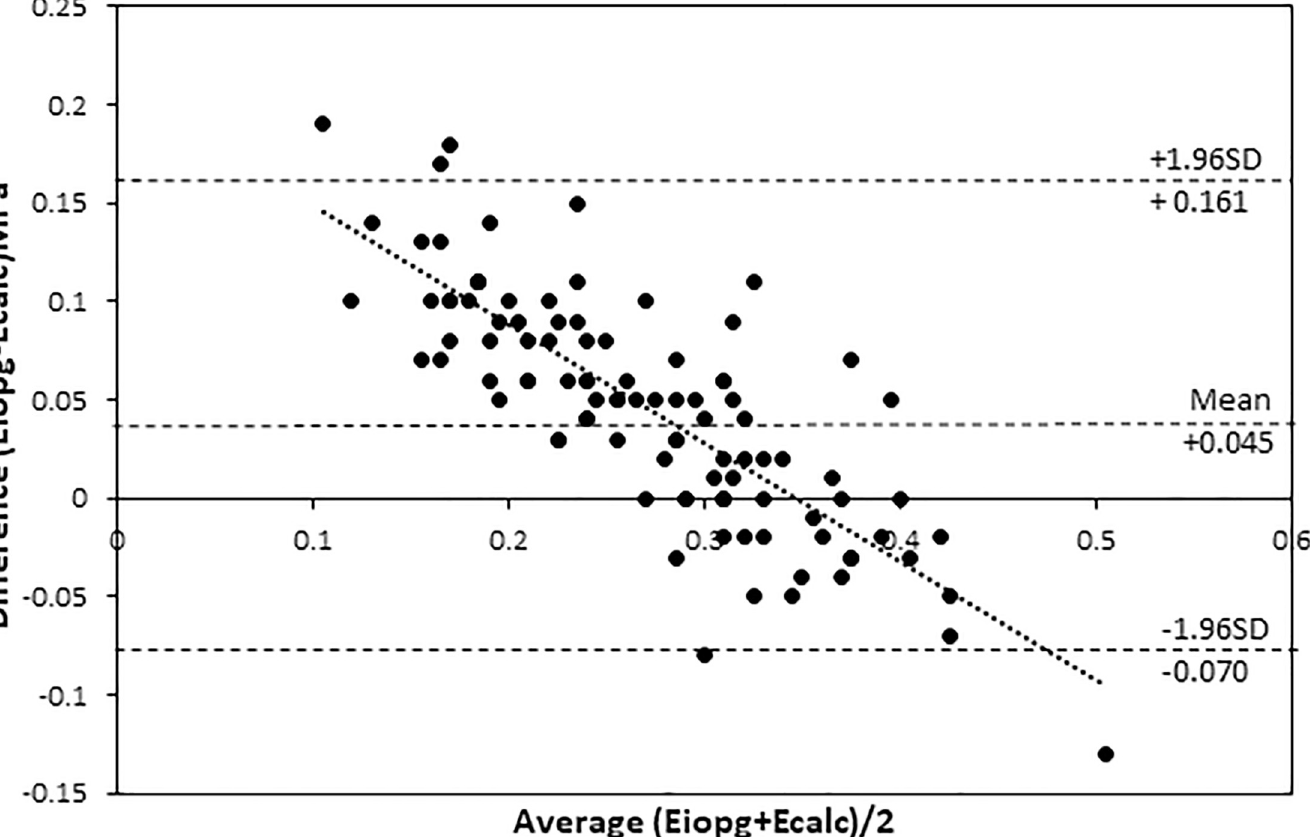
Fig 5. Bland Altman plot of the relationship between Ecalc and Eiopg demonstrating proportional bias.